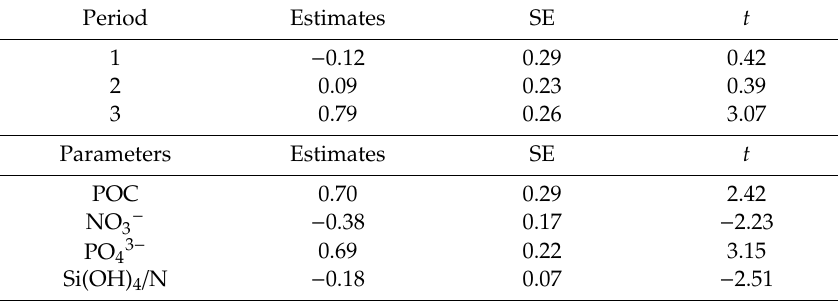
Figure 7. Generalised additive mixed model (GAMM) results: model of Pseudo-nitzschia spp. abundance: smoothers and estimated degrees of freedom ( y axis) showing partial effects of Si(OH) 4 − :N Table 6. Results of the best generalised linear mixed model that shows the effect of abiotic and biotic parameters on particulate domoic acid (pDA) in our database. Station was included as random effect. Parameter estimates with SE and t -values are given. Periods are the same as in Table 4.